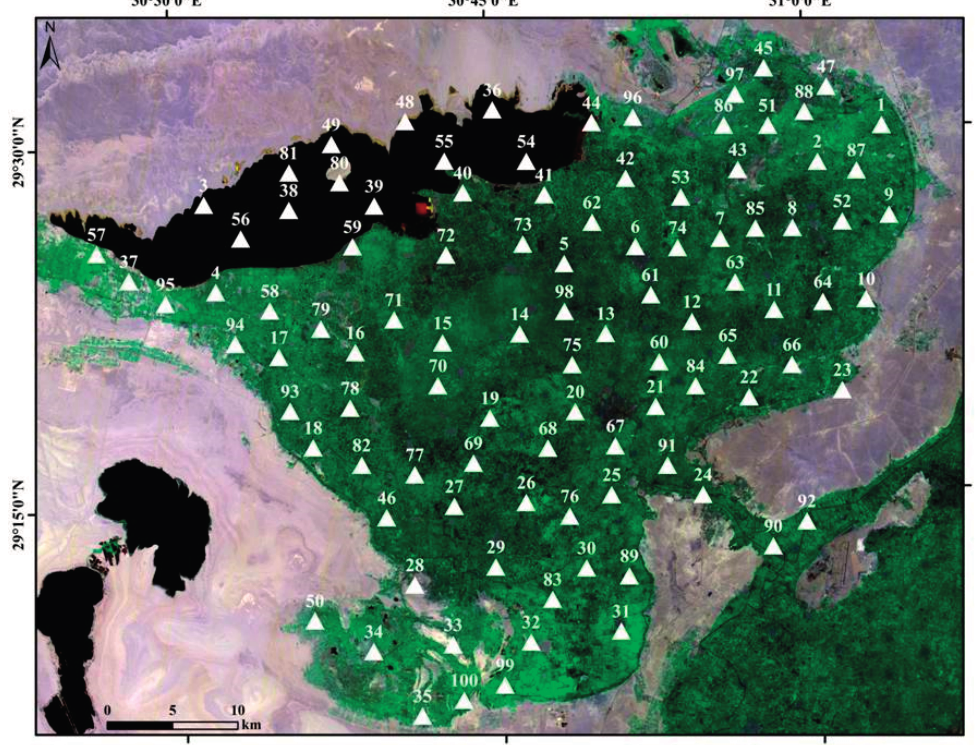
Figure 5. Distribution of 100 locations over the El-Fayoum area (Egypt) for which satellite reflectance data were